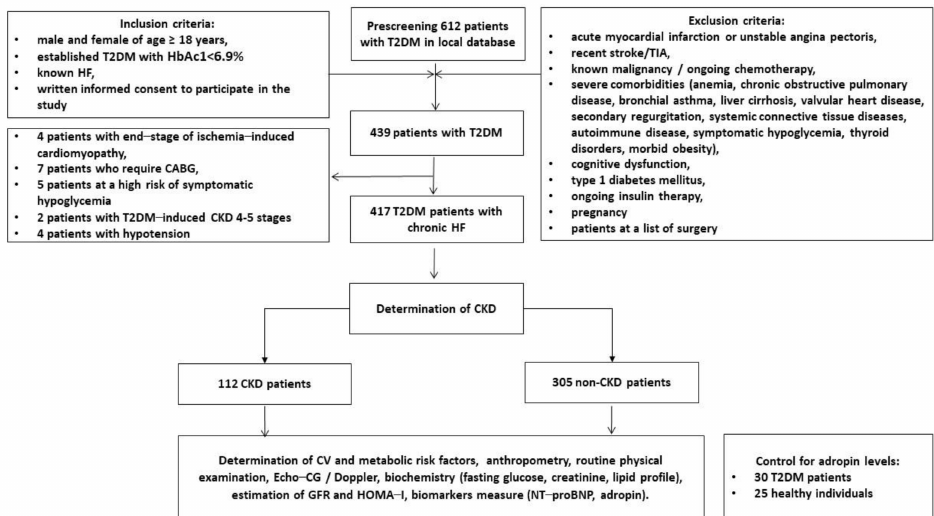
Figure 1. Flow chart of the study design. Abbreviations: CABG, coronary artery bypass grafting; CV, cardiovascular; CKD, chronic kidney disease; GFR, glomerular filtration rate; HF, heart failure; HbA1c, glycated haemoglobin; HOMA–IR, Homeostatic Assessment Model of Insulin Resistance; N–terminal brain natriuretic pro-peptide; T2DM, type 2 diabetes mellitus; TIA, transient ischemic